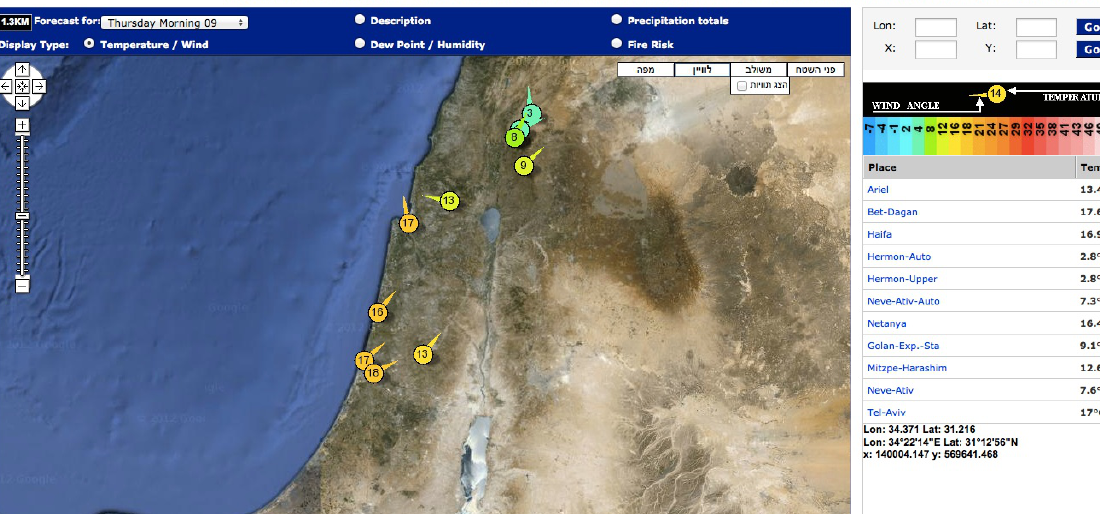
Figure 12. Weather forecast for Israel, which serves as a basis for the fire forecast. Wind and temperature shown to the user. system uses the potential fire behavior (Sect. 2), the mois- ture model (Sect. 4), and the geographic information system (GIS) data sources and conversions (Sect. 6). For operational reasons, this deployment uses coarser meshes on a smaller number of processors. The effect of the feedback from the fire to the atmosphere is reduced, but the benefits of the tight (coupled) integration of the fire simulation with a fine-scale weather forecast